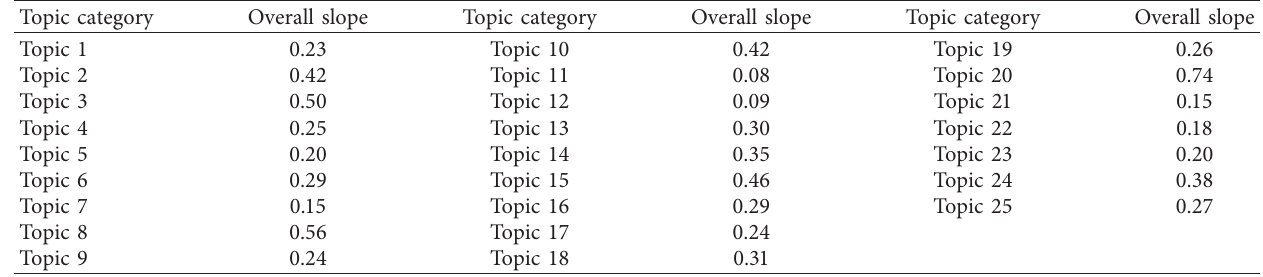
Figure 9: Time series chart of topic popularity in the field of new energy vehicle technology. Table 4: Overall slope of each technology topic for new energy vehicles.